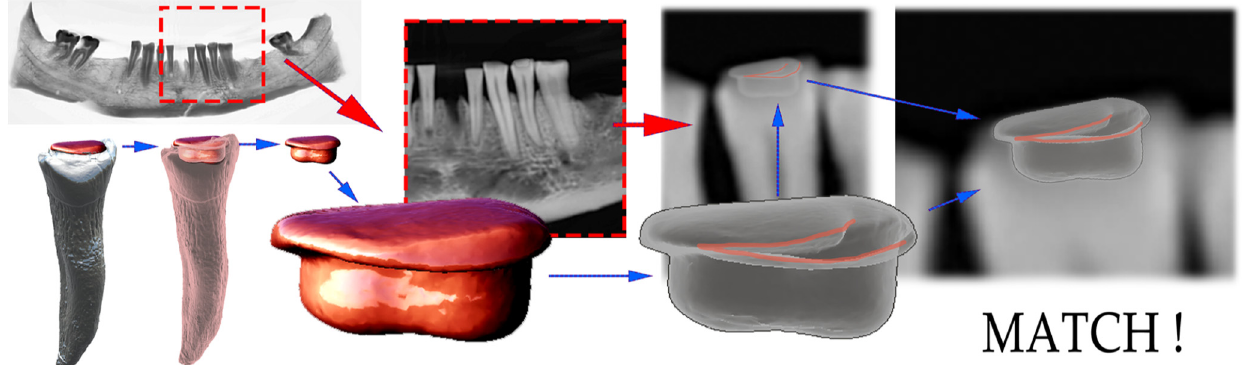
Figure 10. The reconstructed dental pattern of restoration of tooth 43 matched to 2D, representing volume loss over time in tooth, bone, composite, glass-ionomer cement, and amalgam. The representation of composite resin is hidden behind